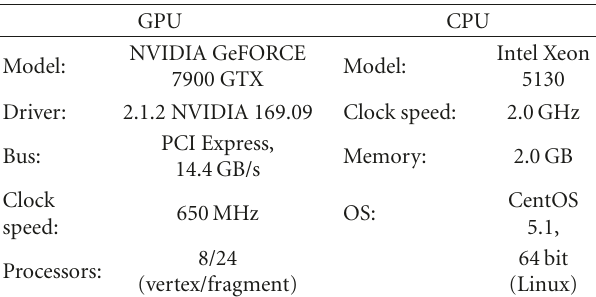
Table 2: Hardware used for the